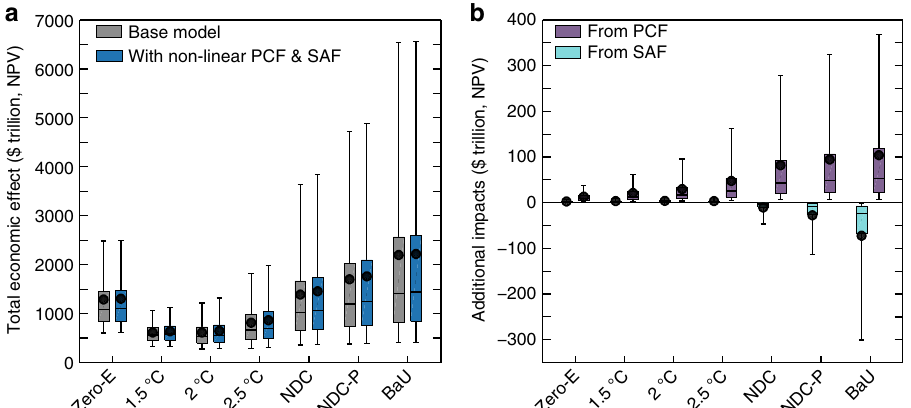
Fig. 5 Total economic effect of climate change with the nonlinear and legacy Arctic feedbacks. a NPVs of the total economic effect of climate change (until 2300, equity-weighted, PTP-discounted), plotted for the legacy Arctic feedbacks (Base model) and with the nonlinear PCF & SAF corrections included, and b NPVs of the additional economic impact separately from the nonlinear PCF and SAF, calculated relative to their legacy values under the climate scenarios considered. Whiskers: 5 – 95% range; boxes: 25 – 75% range; horizontal lines: median; dots: mean. 100,000 Monte-Carlo runs of PAGE-ICE. The effect of the imaginary Zero Emissions scenario is higher compared to the 1.5 °C, 2 °C and 2.5 °C scenarios due to the large mitigation costs. Source data are provided as a Source Data fi